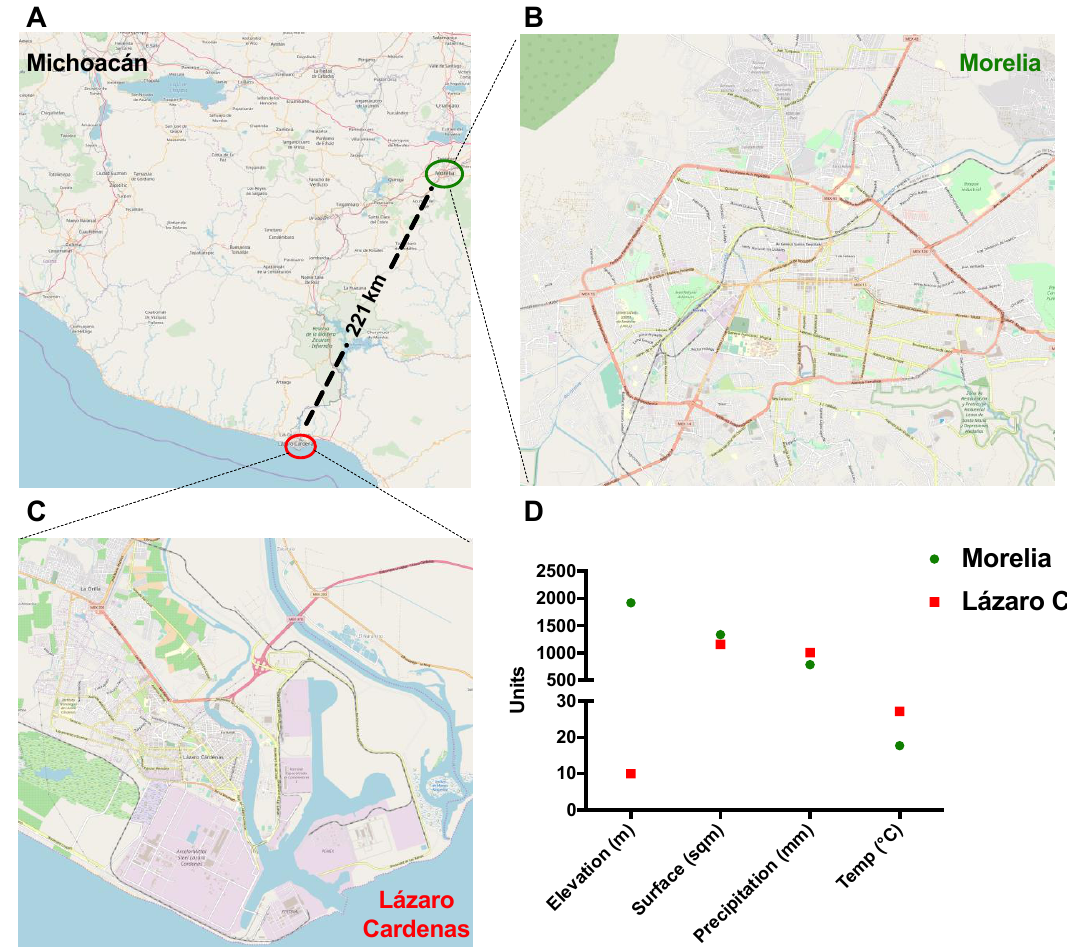
Figure 1. The geographical location of study sites. ( A – C ). Map of Michoacan State in Mexico showing the locations of study sites (Lazaro Cardenas and Morelia) and illustration of the geographical differences between the two municipalities. ( D ). Graph showing the elevation, surface, precipitation, and temperature between the two municipalities.